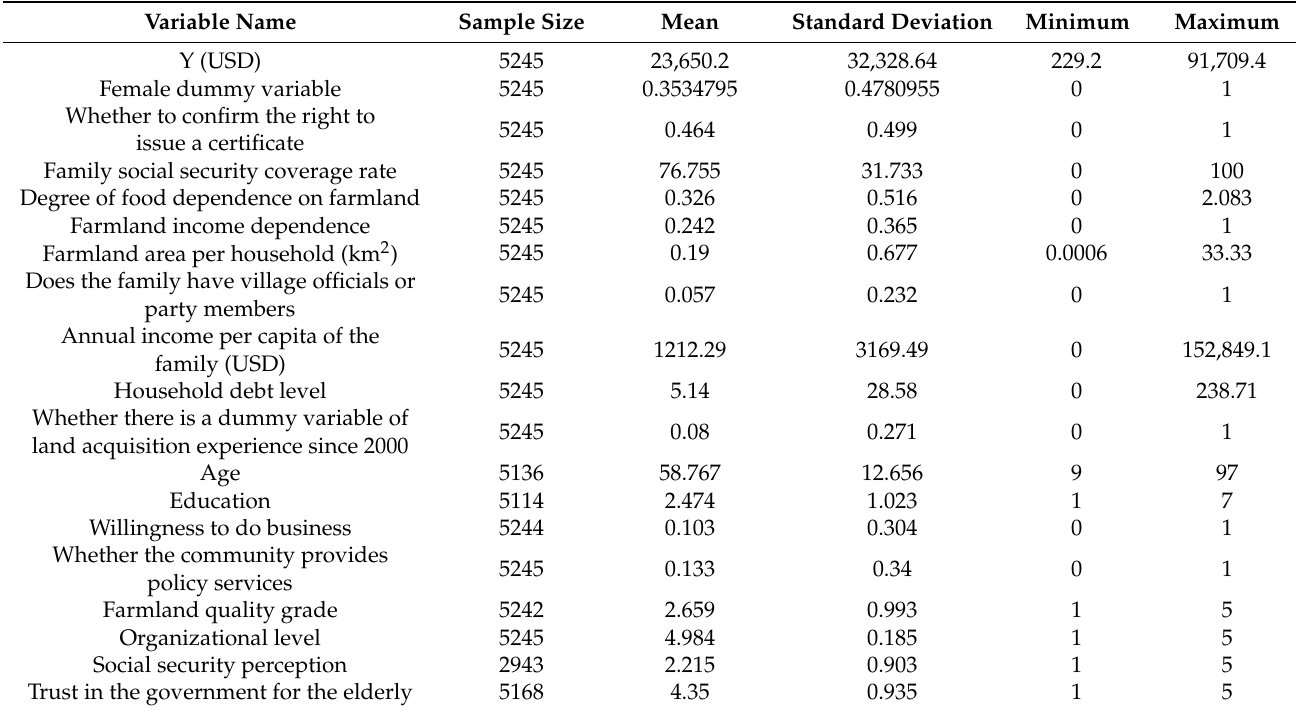
Table 2. Descriptive statistics of main variables.